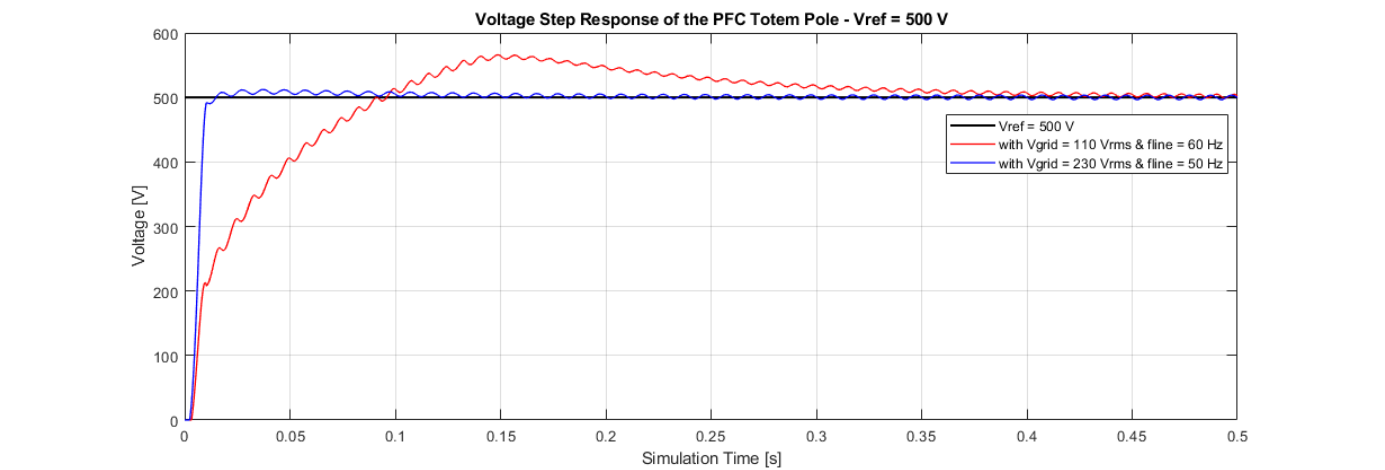
Figure 14. Voltage control of the Totem Pole with V ref = 500